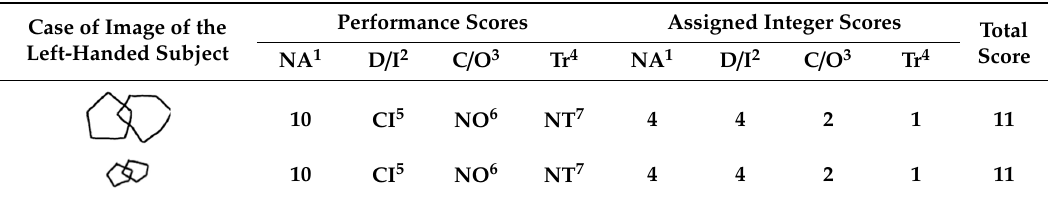
Figure A2. A case of a left-handed female subject (26 years old): ( a ) the original drawing (left) along with the segmented image (middle left) produced by the pre-trained model, Deep5, the corresponding velocity graph (middle right), the corresponding parameter values (right); ( b ) the segmented images generated and analyzed by the pre-trained model, DeepLock (left and middle) and the corresponding parameter values (right); ( c ) the clusters marked on the original drawing (left) and the corresponding parameter values (right); and ( d ) the up and down points marked on the original drawing (left) as well as on the velocity graph (middle) and the corresponding parameter values (right). Table A3. The corresponding drawings and scores for each level with the corresponding detailed parameters of the case of two left-handed subjects.